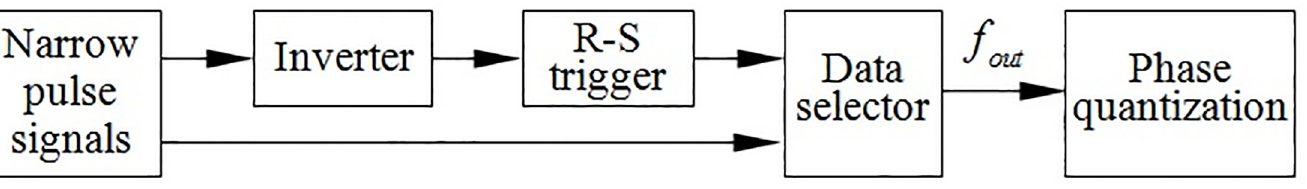
Fig 5. Direct phase comparison